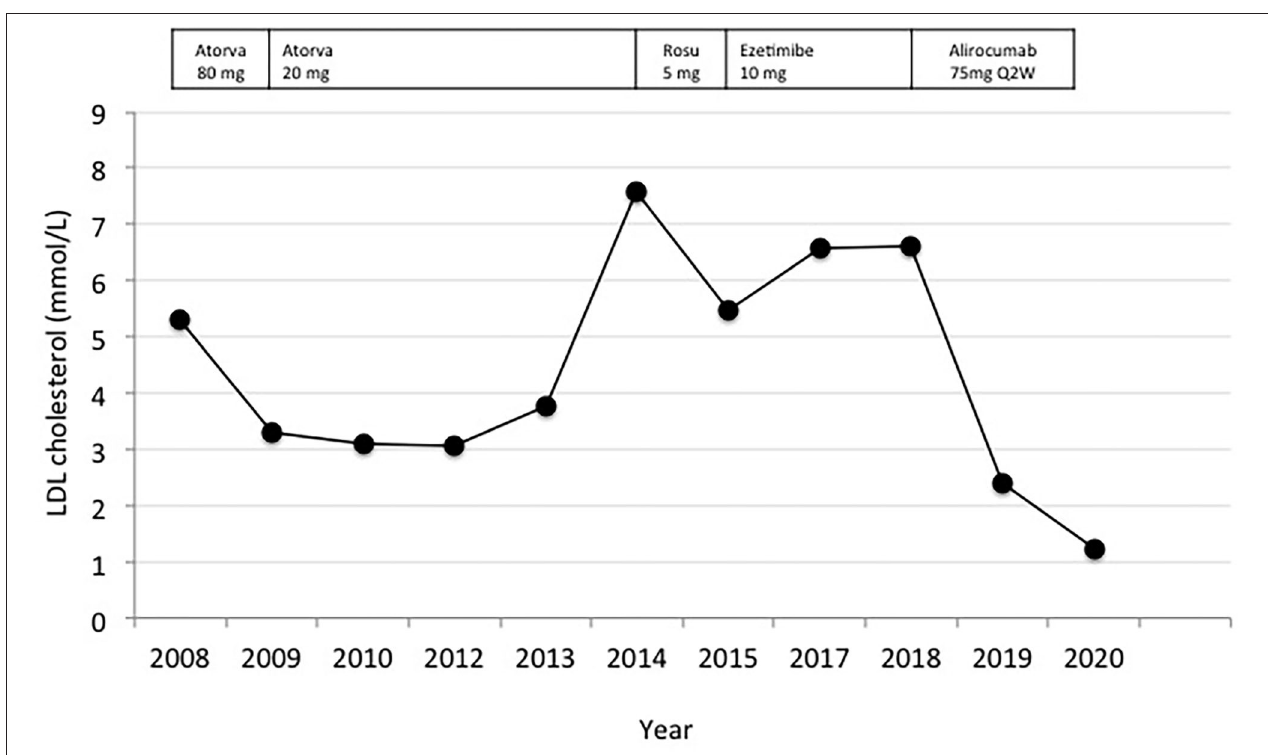
TABLE 1 | Scores of the complete geriatric evaluation at baseline and at 24-month follow-up. Scores at baseline Scores at 24-month follow up Reference values 6 6 From 0 (low function, dependent) to 6 (high function, independent) 5 27.1